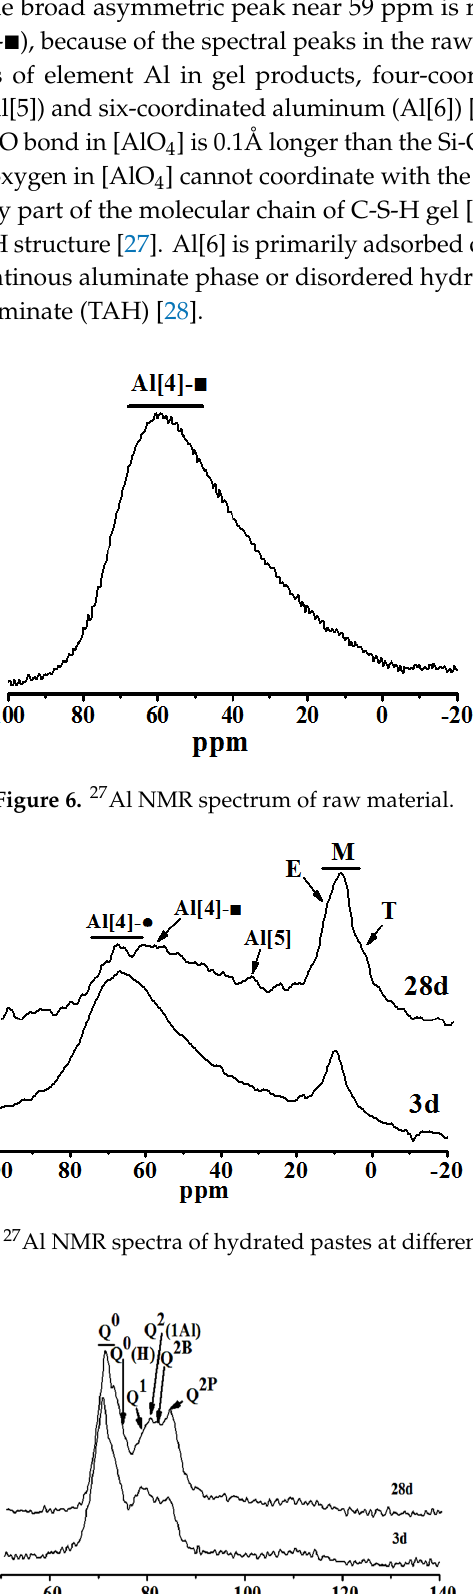
Table 2. Calculation results of deconvolution of Q n in 29 Si NMR spectra.